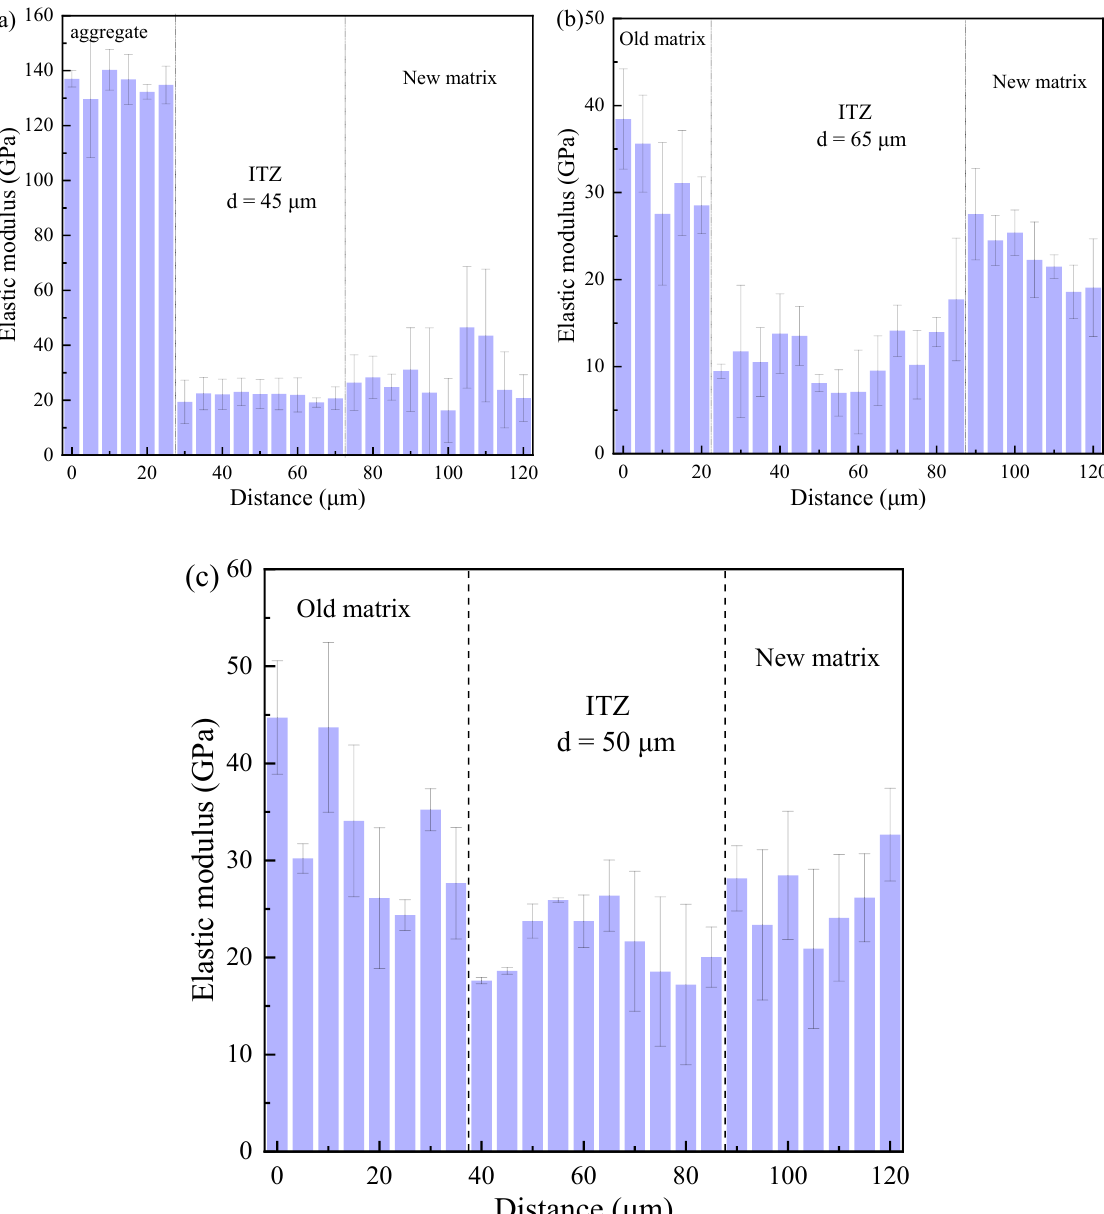
Figure 9. Distributions of modulus for the ITZs ( a ) NAC-100, ( b ) RAC-100, and ( c ) MRAC-100. The environmental effect of RAC is shown in Figure 10b. It can be found that the changing trend of CI value is similar to that of C p value. The NAC-100 sample showed the lowest CI value. The CI value of MRAC sample is lower than that of RAC sample with the same composition. Compared with the NAC-100 sample, the CI value of MRCA sample is improved. However, compared with RAC-100 and RAC-50 with the same composition, the CI values of MRAC-100 and MRAC-50 samples decreased by 18.4% and 13.7%,